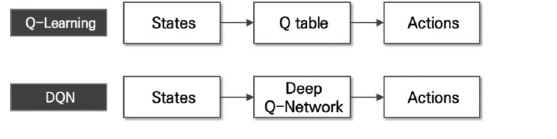
Fig 2. Comparison of Q-learning and DQN.